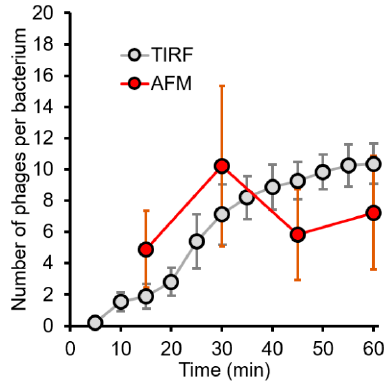
Figure 6. Bacteriophages saturate the bacterial surface over time. The number of docked bacterio- phages followed by TIRF and AFM. N = 24 for TIRF and 9 for AFM.